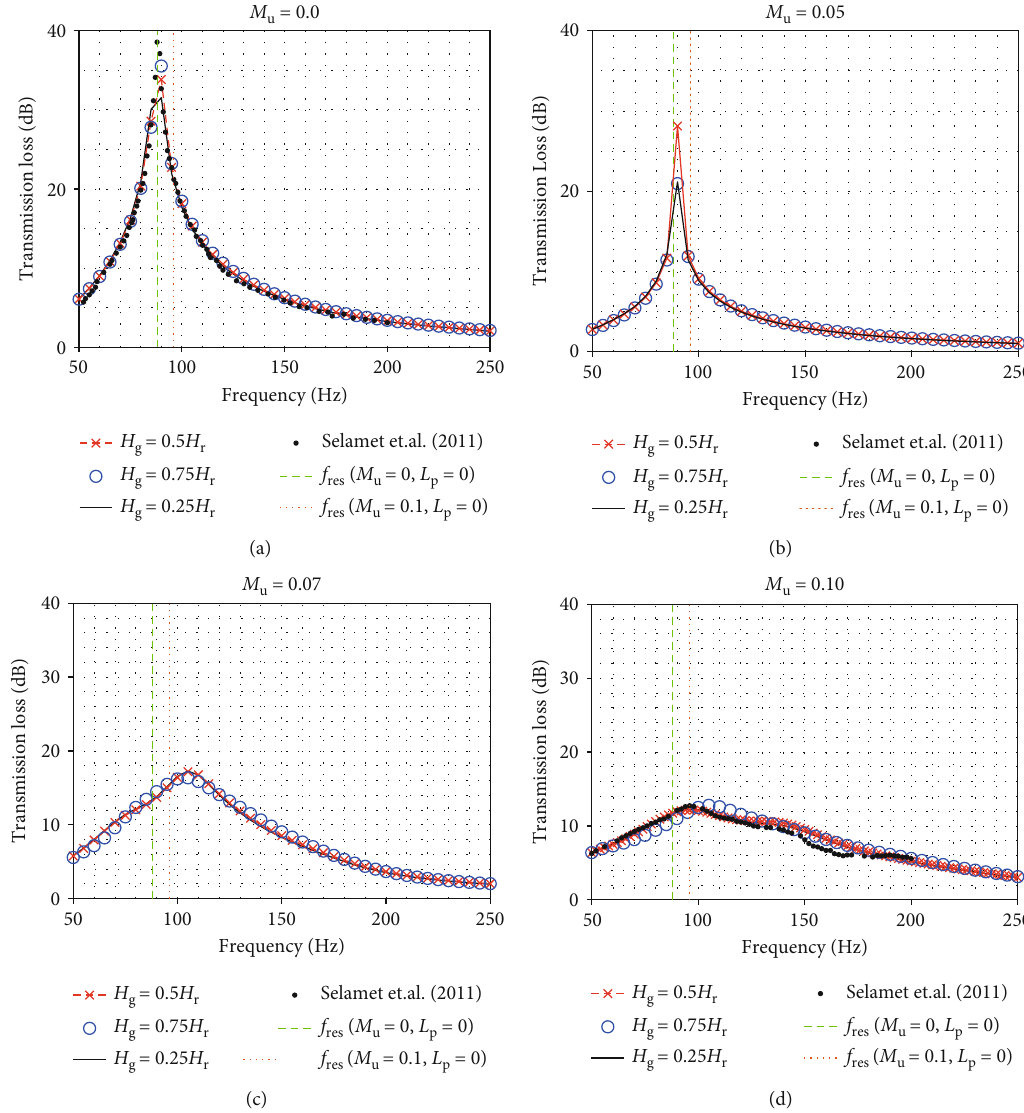
Figure 5: Variation of the transmission loss with forcing frequency, as L / H = 0 : 25 , H H g r